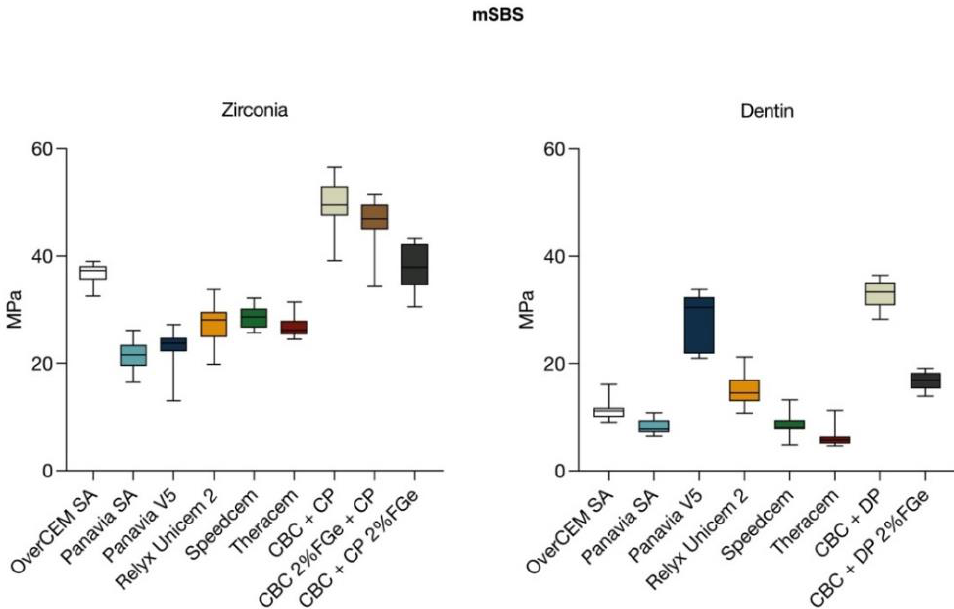
Figure 3. Graphical analysis of values reached by tested materials for mSBS to zirconia and dentin substrates.